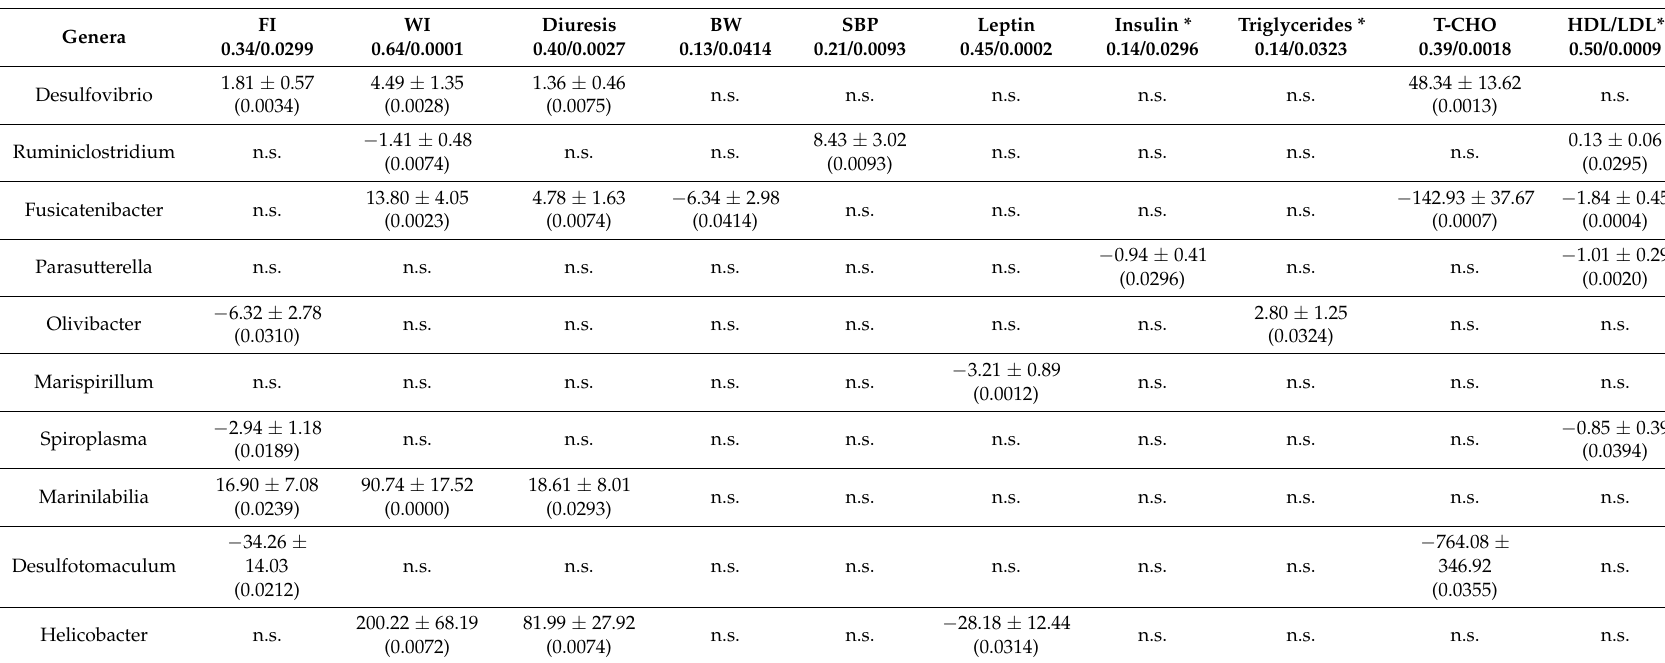
Table 4. Regression analysis for the physiological variables studied and those genera with statistical differences in total